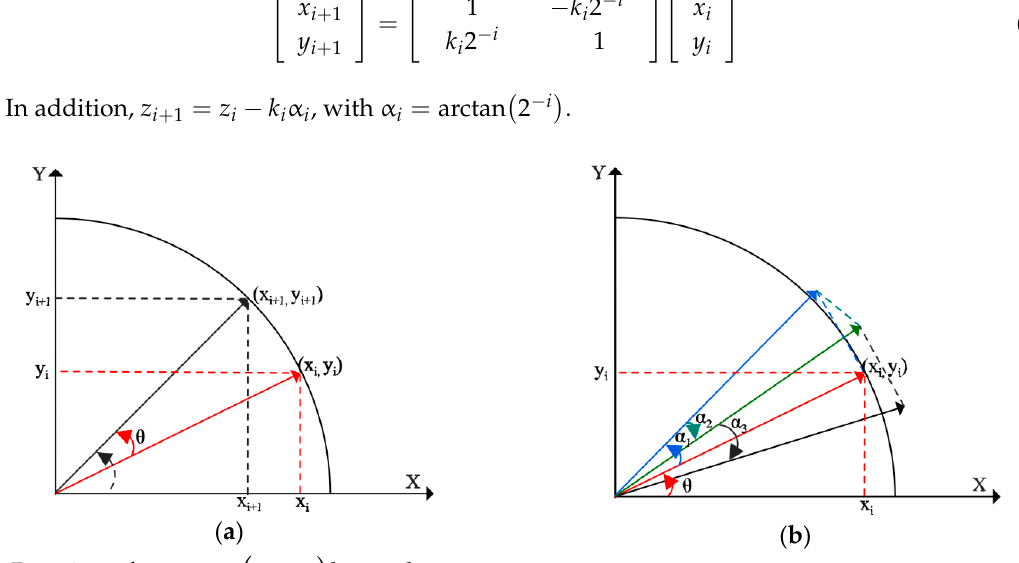
) ( x y , in the x-y plane. Figure 3. Rotation of a vector at the coordinates ( x ) in the x-y i , y i i i